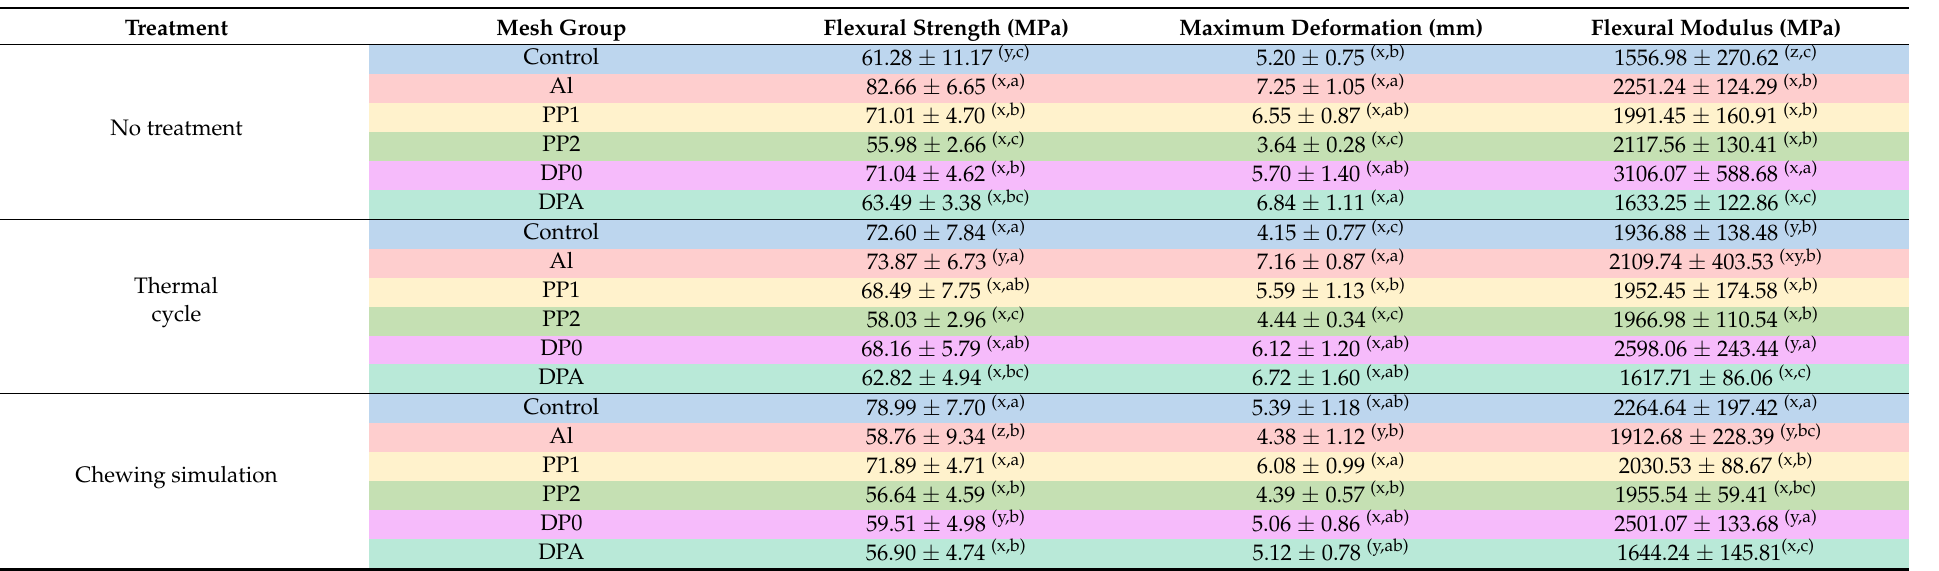
Table 4. Mean, standard deviations, and significance by pairwise comparisons of the three-point bending test